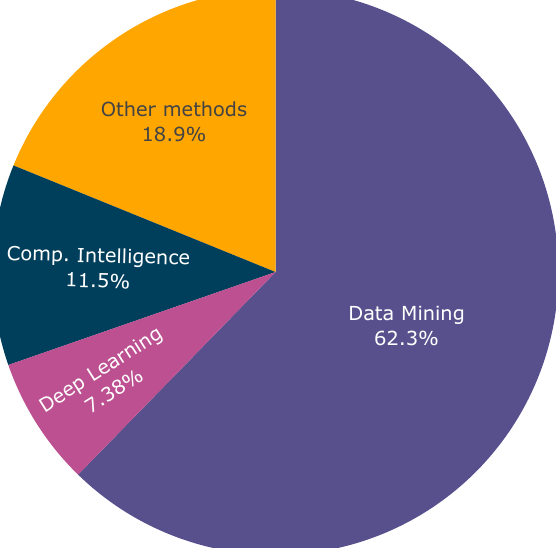
Figure 6. Relative frequency of intelligent methods used by the proposed taxonomy, rounded to three significant digits.